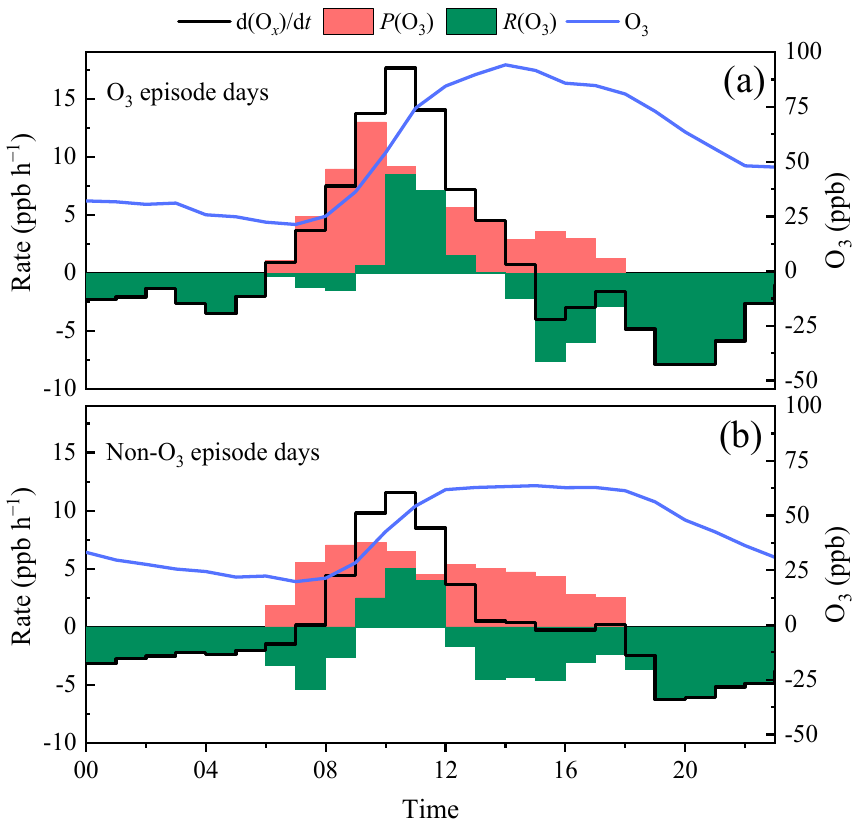
Figure 9. Ozone budget analysis during the O 3 episode days ( a ) and non-O 3 episode days ( b ). As shown in Figure 9, the maximum values of P (O 3 ) were 13 ppb h − 1 (O 3 pollution period) and 7.31 ppb h − 1 (non-O 3 pollution period) at around 09:00, respectively, and the increase in the O x mixing ratio is close to the local ozone production rate, indicating that the fast O 3 mixing ratio increase in the morning (around 06:00–09:00) is mainly caused by local photochemical production. However, both positive R (O 3 ) values for the different pollution periods were observed at around 09:00–12:00, indicating that the local ozone budget was O 3 importing. Specifically, during the O 3 pollution period, the R (O 3 ) values at 10:00 and 11:00 were 8.46 ppb h − 1 and 7.31 ppb h − 1 , respectively. They are responsible for 47.9%